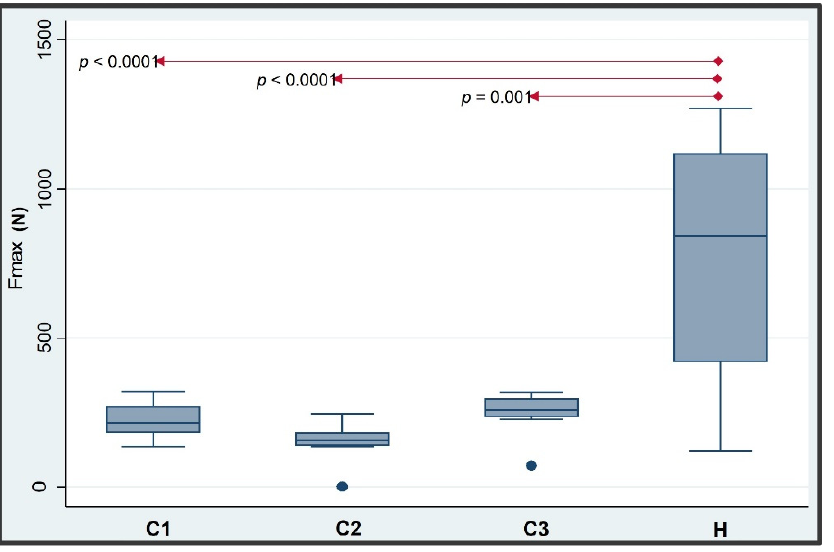
Figure 9. The boxplot diagram demonstrated the pull-off failure loads of the groups ( n = 31). Horizontal red lines represented statistically significant differences between the four groups.